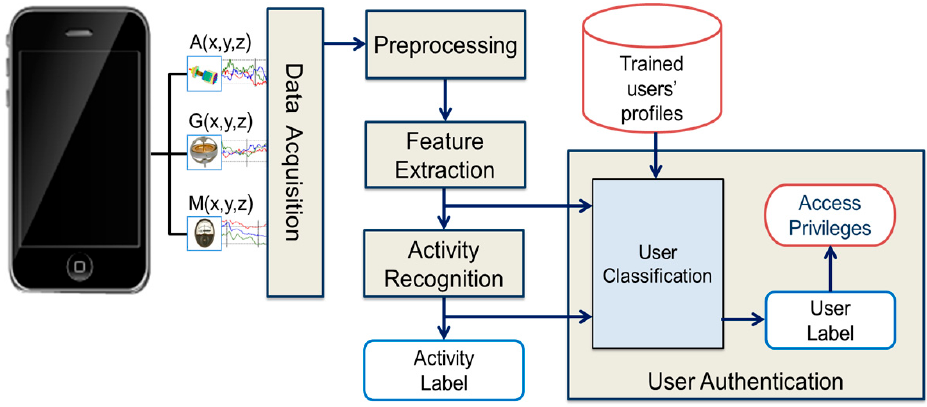
Figure 2. Proposed methodology for smartphone user authentication.